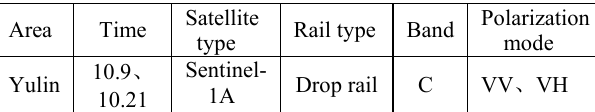
Table 1. Satellite data related parameters